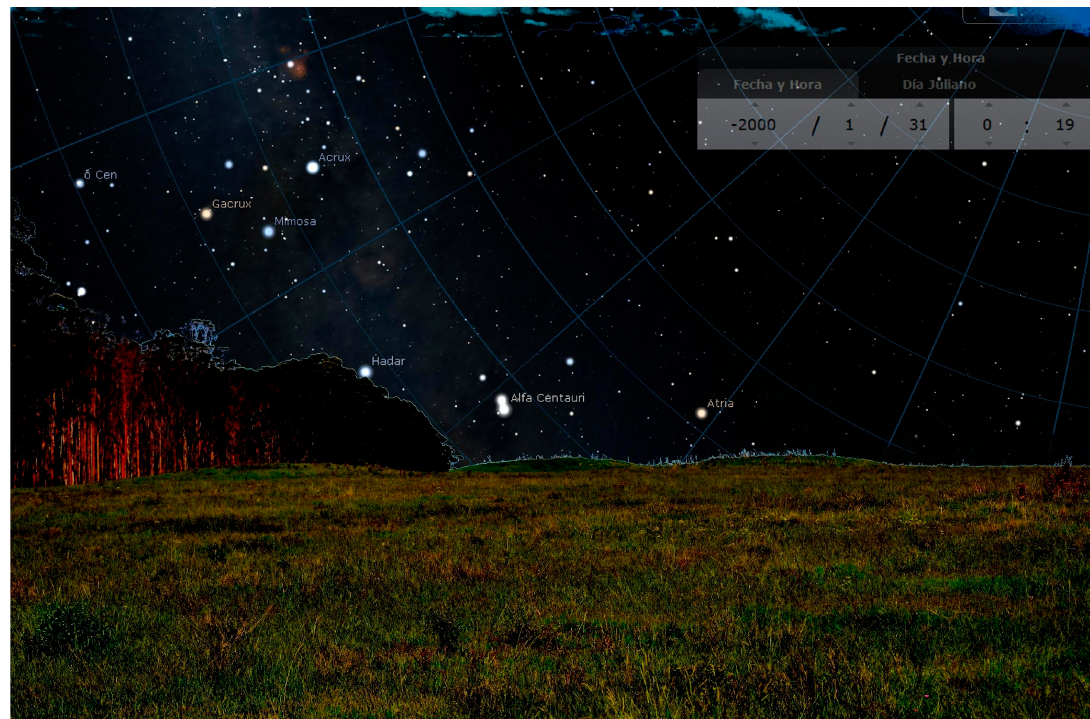
Figure 6. Stellarium image of mounds for the Los Ajos complex silhouetted on the horizon with Southern Cross in the background. The image was obtained from the top of one of the central mounds in the elongated part of the Los Ajos arrangement. Three mounds can be seen defining the skyline; in this case, both ⍺ and ꞵ Cen and the Southern Cross can seen rising behind those mounds.